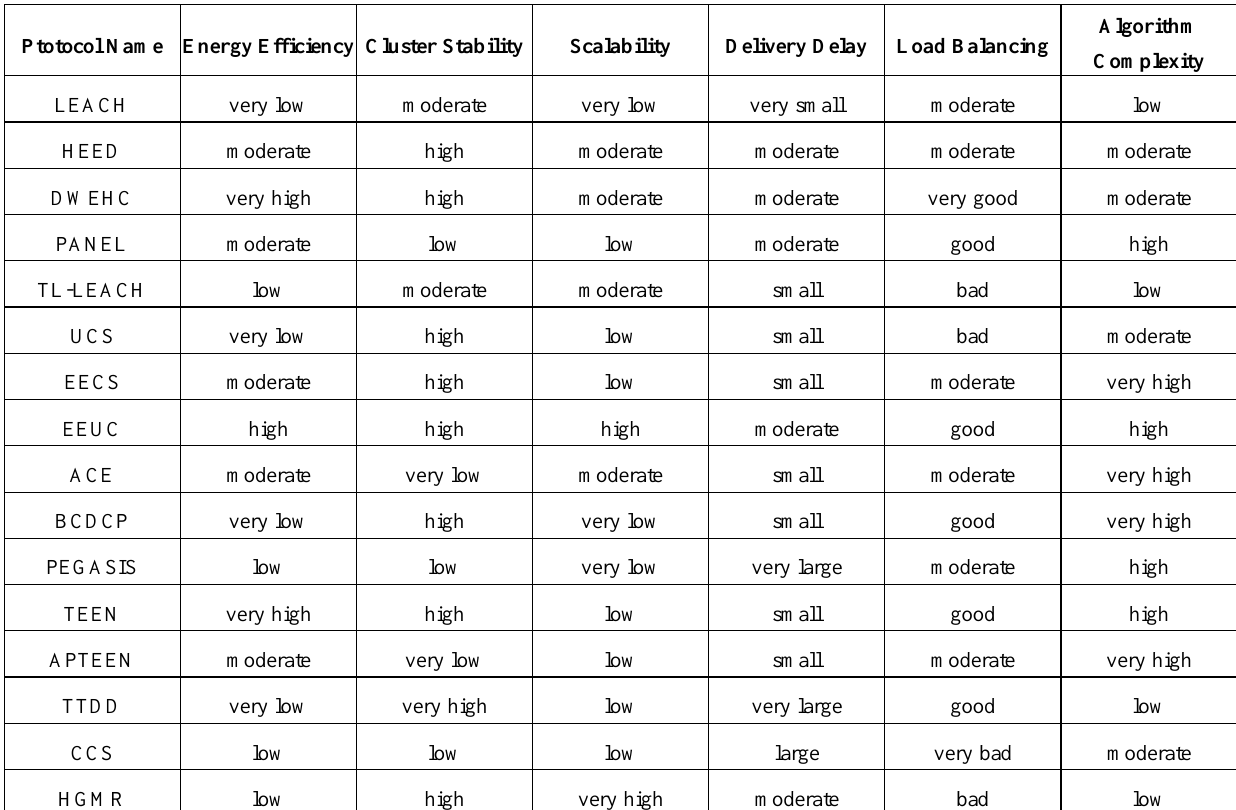
Table 3. Comparison of Different Clustering Routing Protocols in